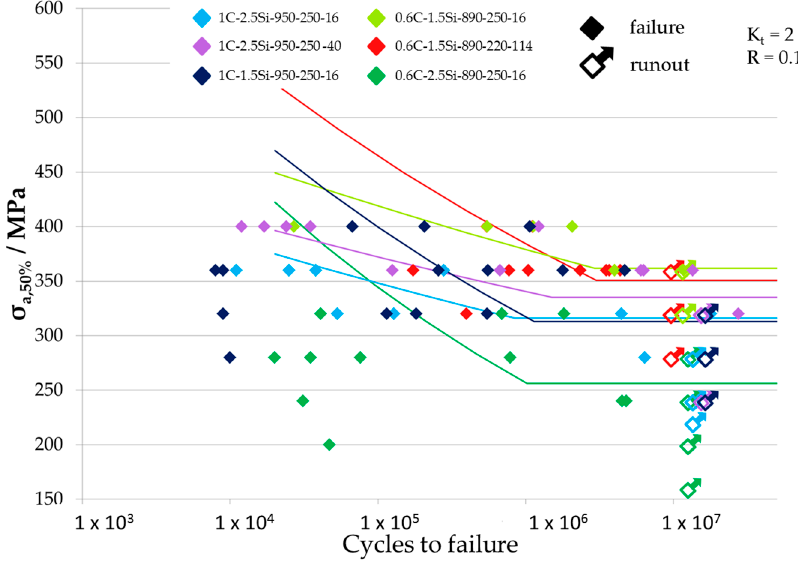
Figure 7. Woehler curves of the variants tested at specimens with K t = 2 and a load ratio R = 0.1.